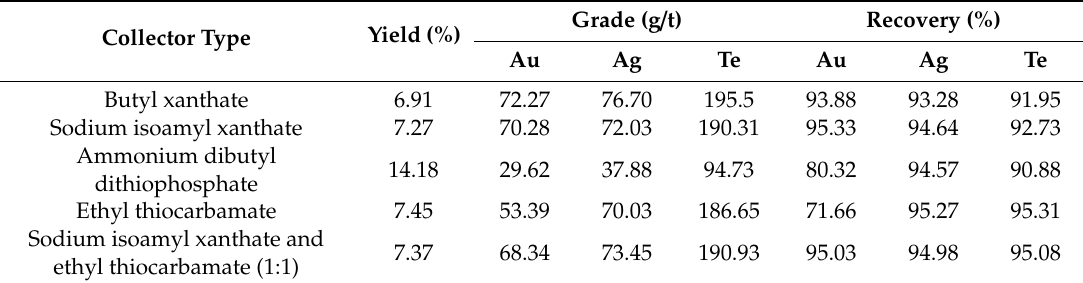
Table 3. Flotation recovery and grade of Te, Au, and Ag of collector type value.